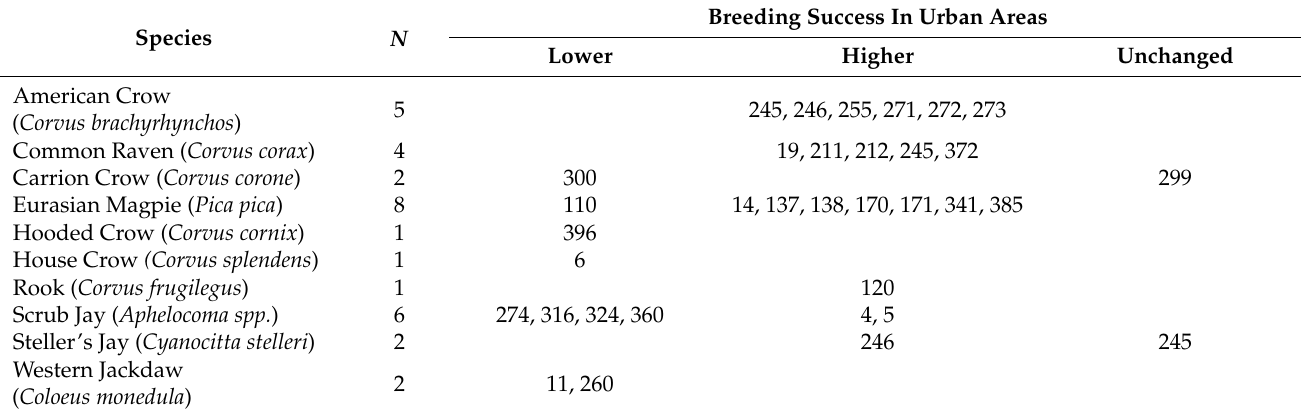
Table 2. Articles reporting lower, higher or no effects on breeding success in urban areas relative to rural areas in different corvid species ( n = 31). The reference numbers in the table refer to the individual publication numbers given in Table S2.